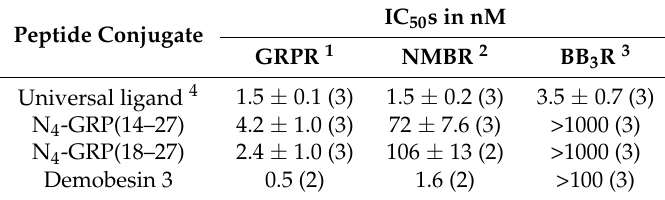
Table 1. Affinities for the three human bombesin receptor